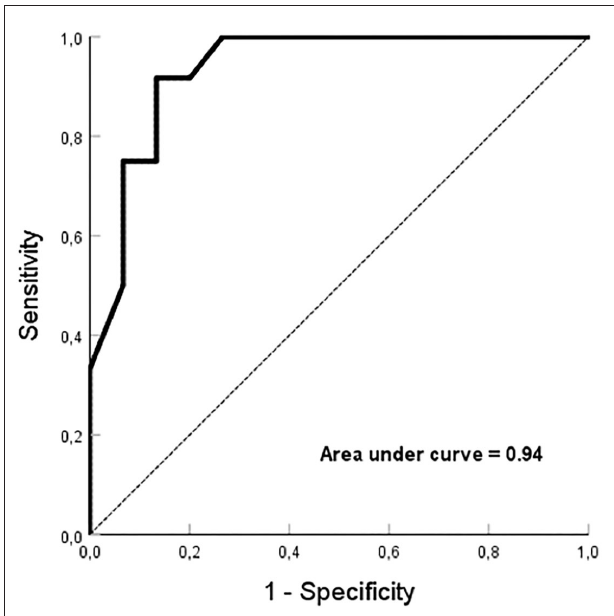
FIGURE 5 | Receiver Operating Characteristic curve analysis. The sum of ≥ 60% for time-difference ratios in both the longitudinal and transverse directions, is employed as a cut-off value for the fractionated potentials responsible for microreentrant atrial tachycardia with an area under the curve of